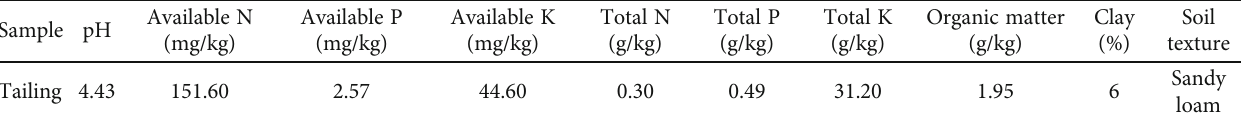
Table 1: Basic physical and chemical properties of the soil substrate in rare earth mine tailings. Available N Sample pH